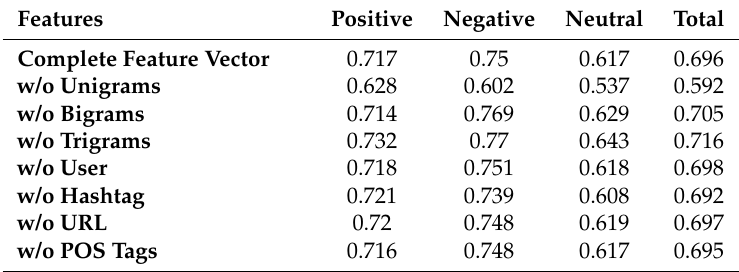
Table 13. F-Measure for Ternary Classification for Naive Bayes for 12,500 tweets.